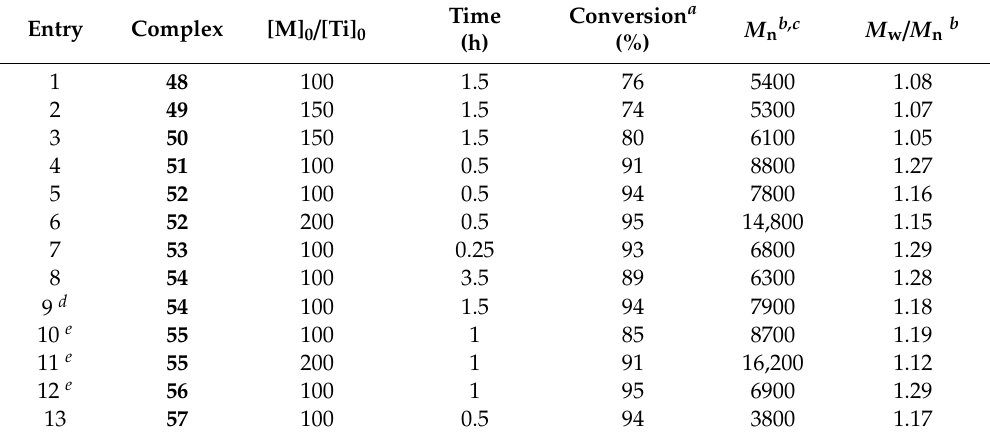
Figure 13. Diphenolate-supported mixed heterobimetallic Ti complexes [27]. Table 15. ROP of L -LA catalyzed by bimetallic Ti-diphenolate complexes 48–57 [27].